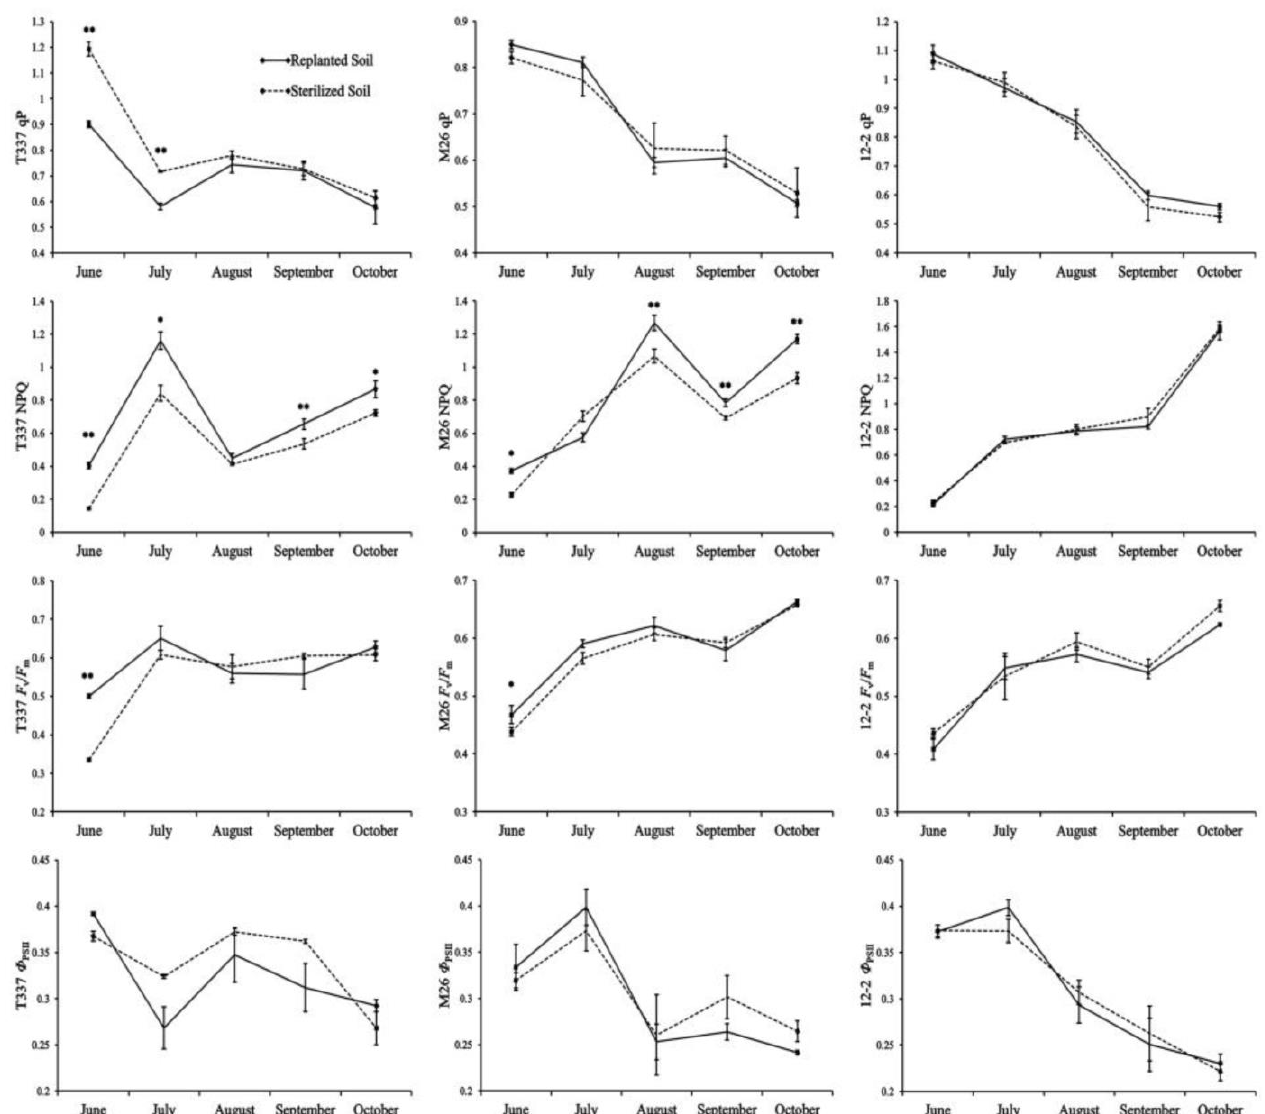
Figure 3. Fluorescence (qP, NPQ, F v /F m , and Φ PSII ) in the leaves of plants with different rootstock types planted in sterilized and replanted soil. Effects of replanted soil on fluorescence of leaves from the different rootstock treatments.